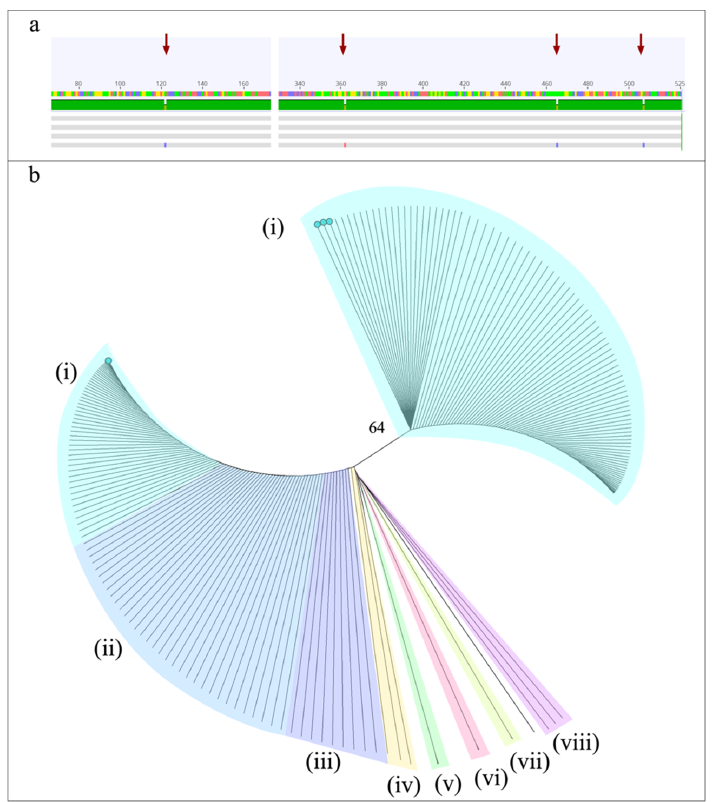
Figure 2. ( a ) Alignment of the four sequences obtained in this study showing four SNPs (red arrows), ( b ) Neighbor joining consensus uprooted phylogenetic tree constructed with ITS ribosomal sequences of (i) Rhizopus arrhizus , (ii) R. delemar , (iii) R. oryzae , (iv) Mucor spp., (v) Cokeromyces spp. and Rhizomucor sp., (vi) Apophysomyces variabilis , (vii) Thamnostylum lucknowense , (viii) Lichtheimia hyalospora . The sequences reported in this study are indicated with green dots.